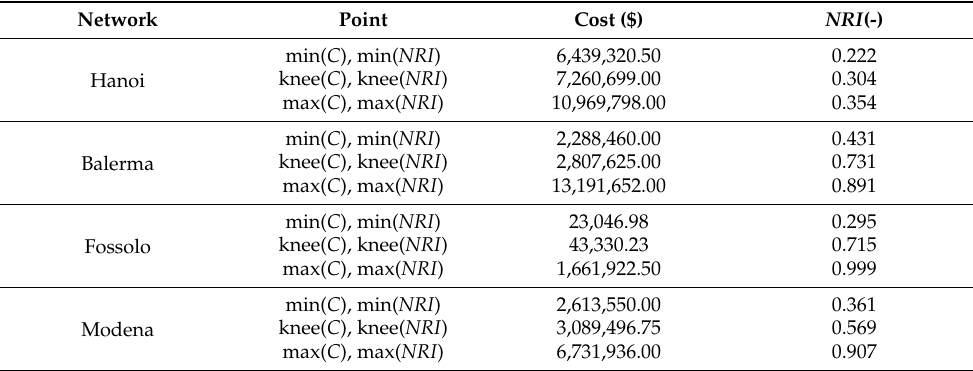
Table 3. Cost and NRI for the three selected points of each network: [min( C ), min( NRI) ], [knee( C ), knee( NRI )], and [max( C ), max( NRI